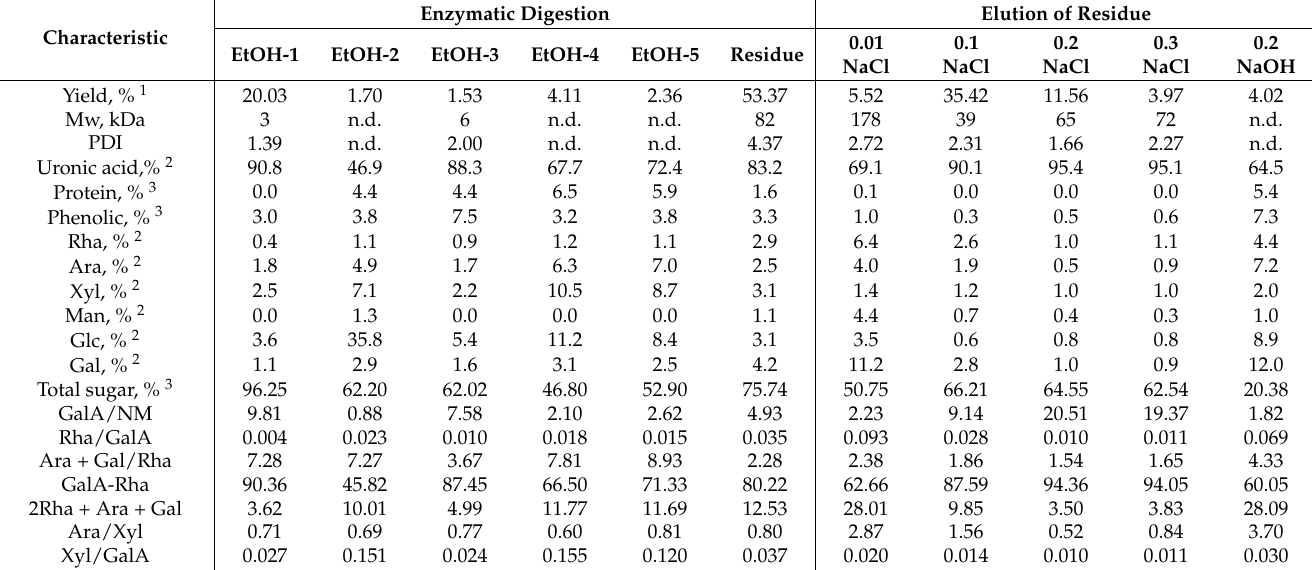
Table 3. Chemical characteristics of the polysaccharide fractions (1–5 and residue) obtained by fractionated precipitation with ethanol of products of the enzymatic digestion of EA-4.0 and chemical characterization of the polysaccharide fractions obtained during fractionation of residue of enzymatic digestion on DEAE-cellulose column (OH − ). Enzymatic Digestion Elution of Residue Characteristic